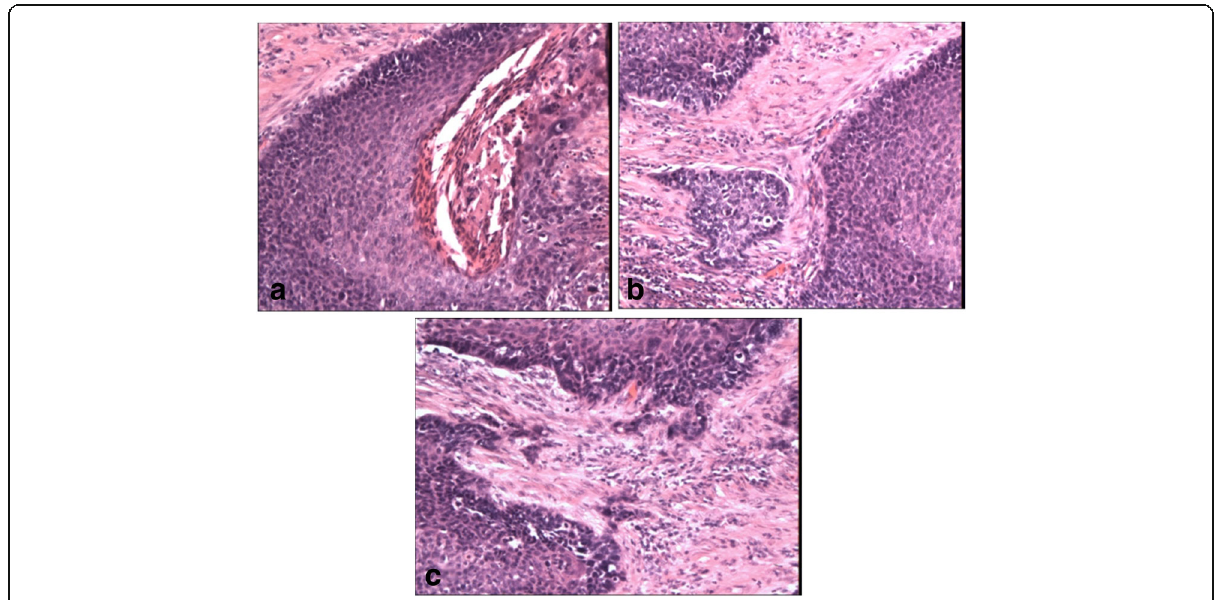
Fig. 1 Histopathology of test specimens. a Well differentiated tumor tissues of LSCC (H&E, × 100). b Moderately differentiated tumor tissues of